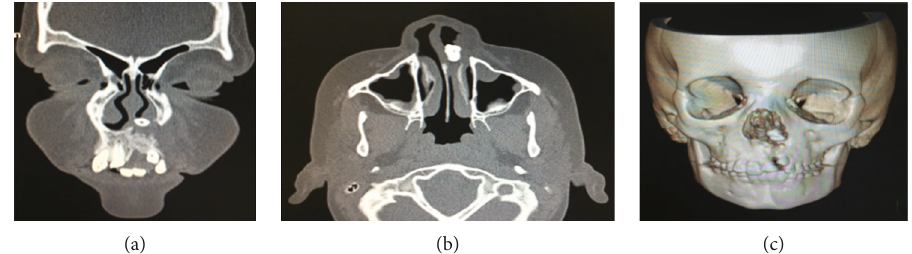
Figure 3: (a, b) CT scan showing intranasal location and soft tissue surrounding the dysmorphic tooth. (c) 3D reconstruction of CT scan showing the ectopic position of element 21.